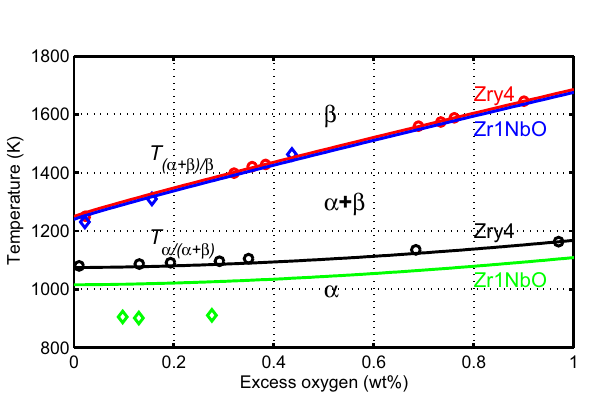
Figure 1. Phase boundary temperatures versus metal excess oxygen concentration for Zircaloy-4 (circles) 14 , Zr-0.5%NbO (blue diamonds) 15 , and Zr-1%Nb (green diamonds) 16 . The lines are empirical correlations for Zry4 and Zr1NbO